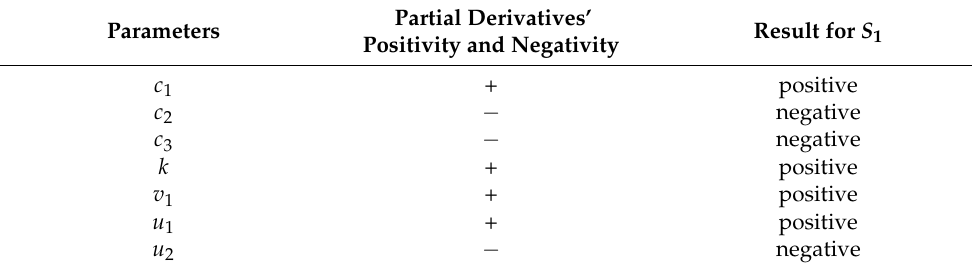
Table 4. Impact analysis of